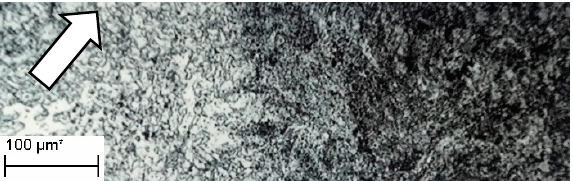
Figure 10. The fusion area (indicated by the arrow) of the HAZ of the welded joint, Template 3 (see Figure 11). ×400. *—mkm.